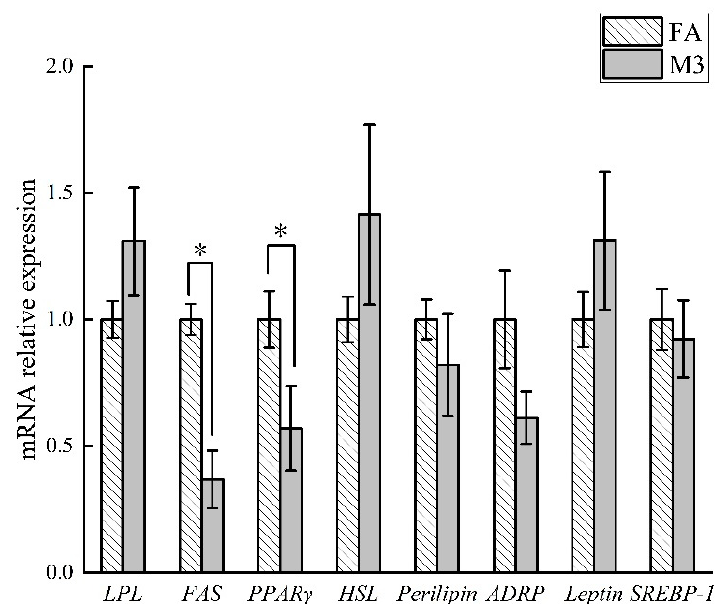
Figure 2. Effects of feeding frequency on enzyme activity of lipid metabolism in growing–finishing pigs. FA, pigs had free access to feed; M3, pigs were given three meals per day (06:00, 14:00, and 22:00 h); * p < 0.05; ME, malic enzyme; G-6-PDH, glucose-6phosphate dehydrogenase; FAS, fatty acid synthase.